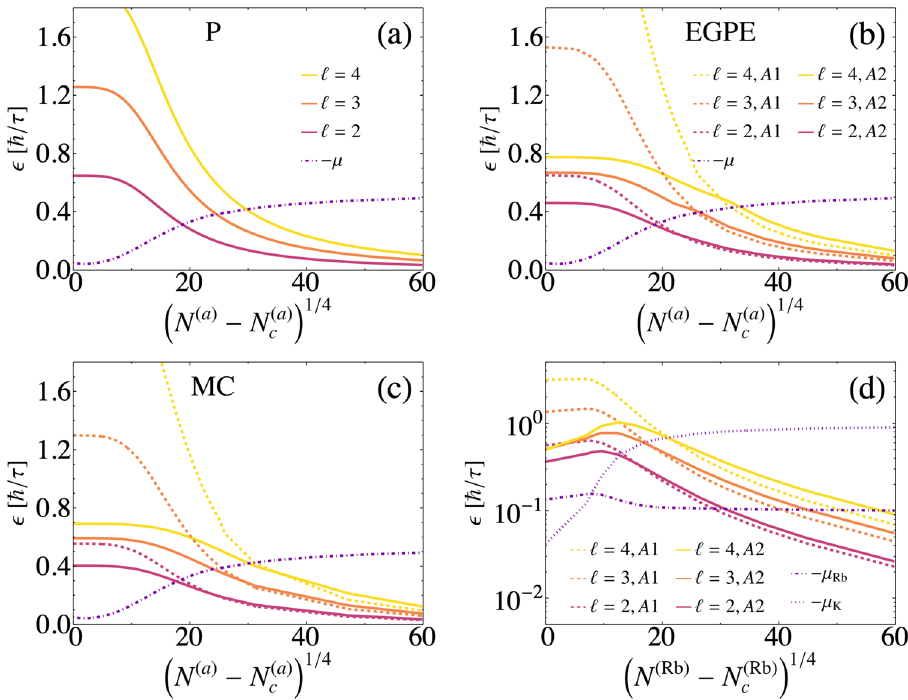
Figure 2. Approximate excitation energies ǫ ℓ as a function of the number of atoms N for ( a – c ) a homo–nuclear mixture of 39 K atoms; ( d ) a hetero-nuclear mixture of 41 K and 87 Rb atoms. The negative value of the chemical potential µ is also shown. ǫ ℓ is evaluated according to different models: ( a ) a phenomenological expression expected to be valid just for N ≫ N c 2 (P); ( b , d ) the variational scheme for the LHY-EGPE, Eqs. (21–22); ( c ) the variational scheme for the effective interaction obtained from Monte-Carlo (MC) 16 . In ( b – d ) the results from ansatz 1, A1, (dashed) and ansatz 2, A2, (continous) are shown. The natural unit (cid:31) /τ of energy is used with τ = 1.308 ms (homo-nuclear) and τ = 1.191 ms